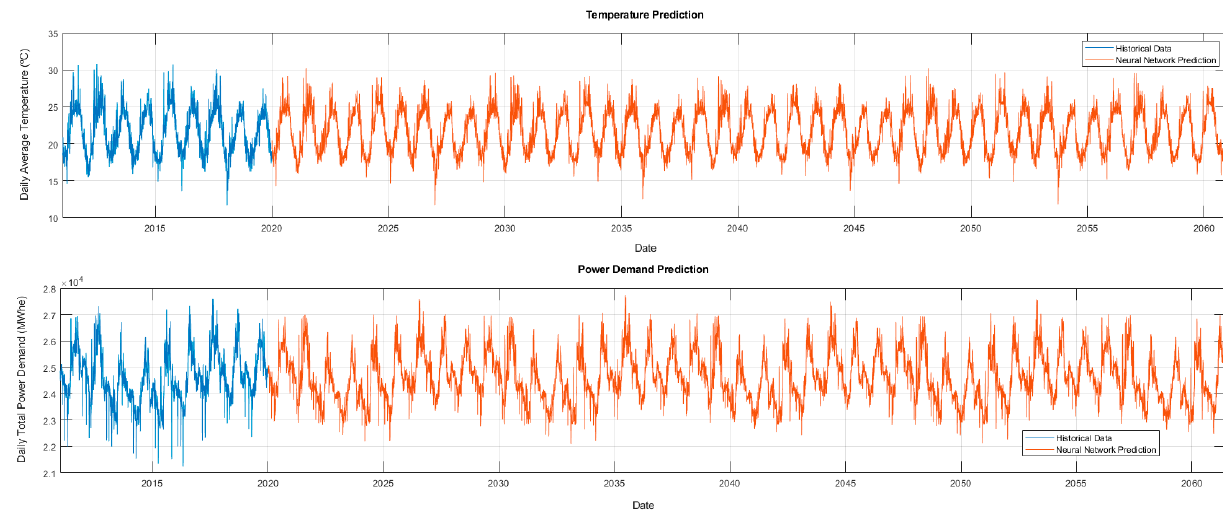
Figure 13. Neural network prediction results.